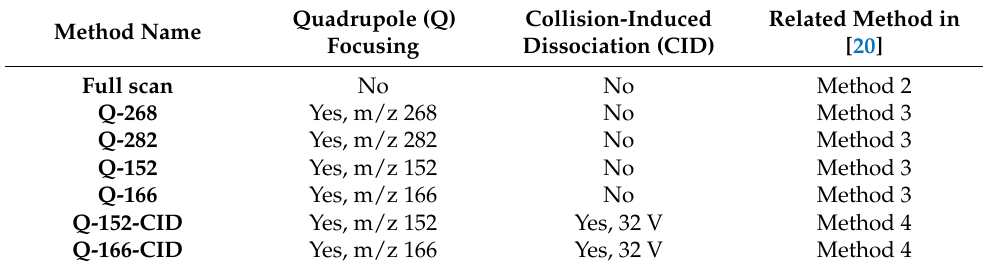
Table 1. Description of the applied mass spectrometric